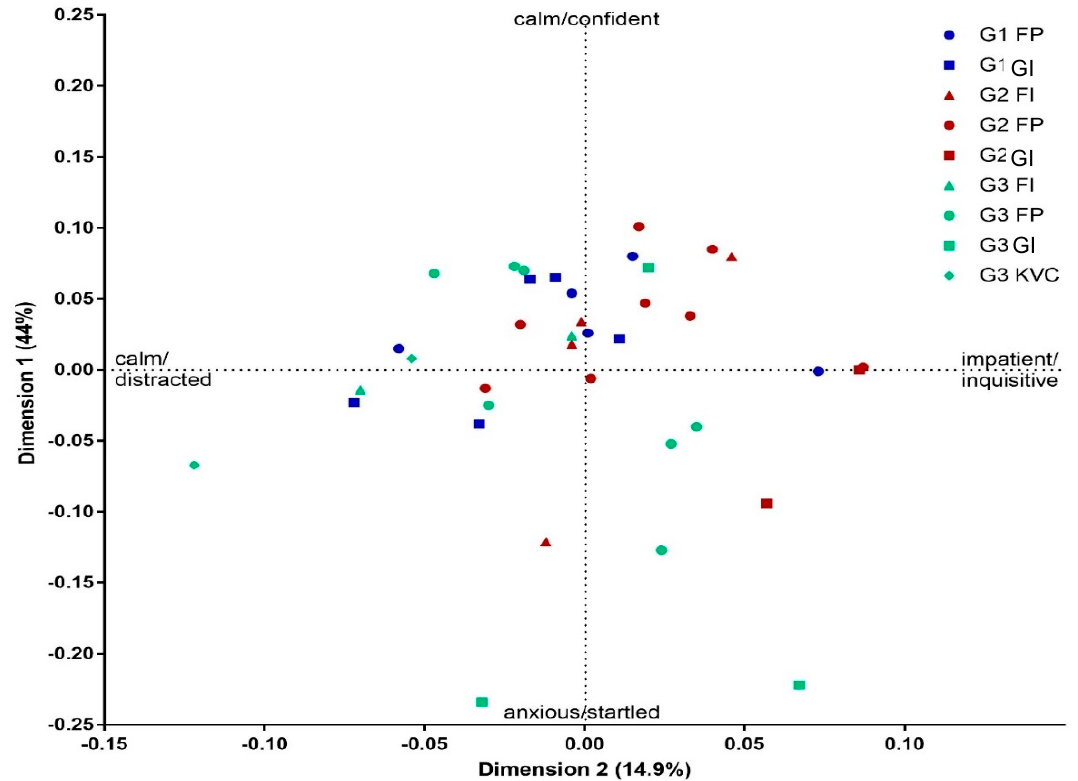
Figure 2. Score plot of video clips labelled to show different Keeper-animal interaction (KAI) events and individual giraffes. The x and y axis reflect the generalized procrustes analysis (GPA) scaling values for relative differences between video clips on dimensions 1 and 2.